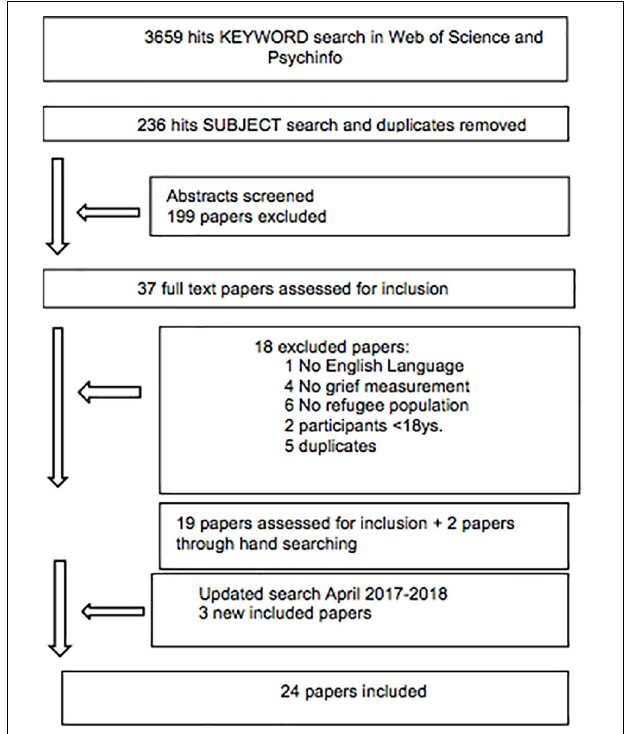
FIGURE 1 | Flow chart of search